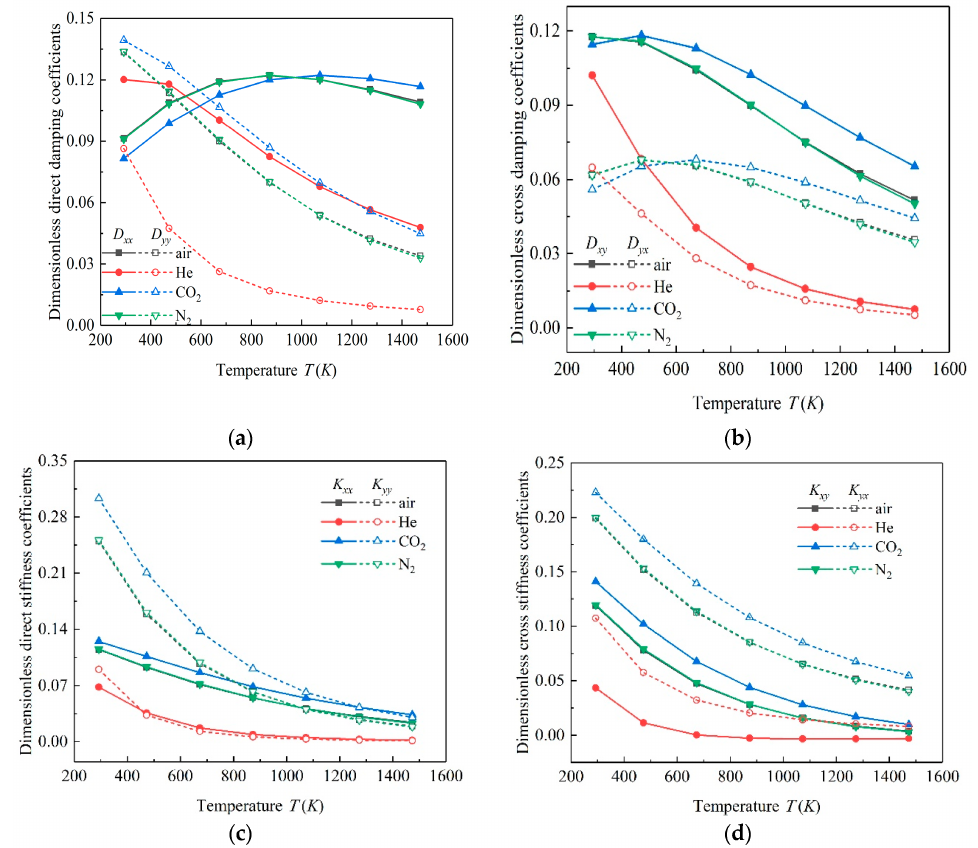
Figure 8. Variation of dynamic coefficients. ( a ) direct damping coefficients; ( b ) cross damping coefficients; ( c ) direct sti ff ness coe ffi cients; ( d ) cross sti ff ness coe ffi